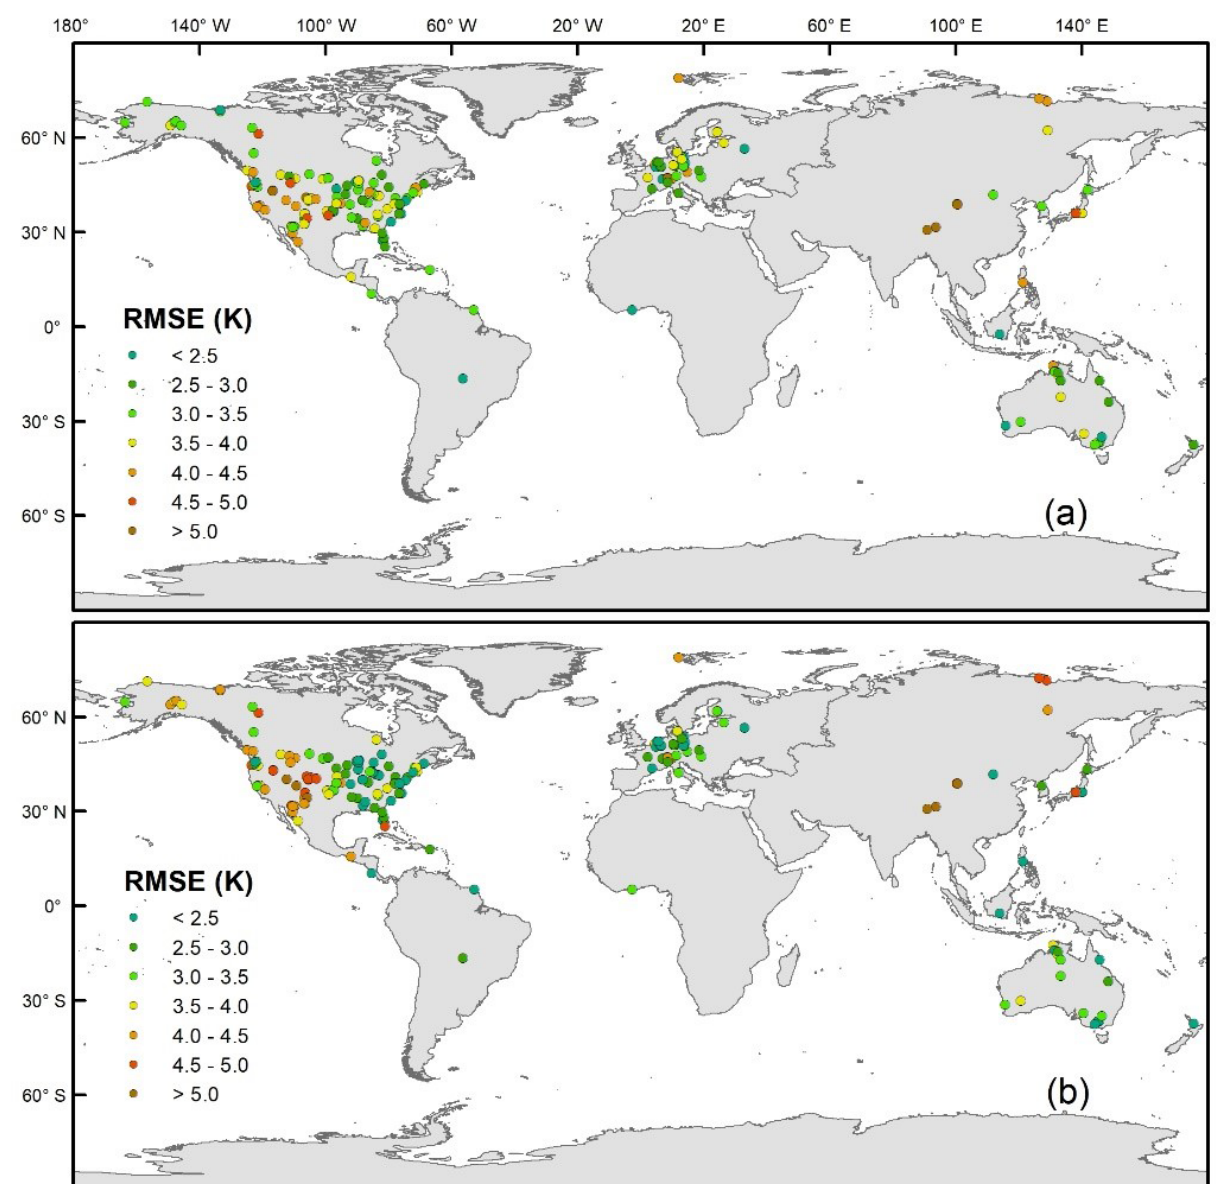
Figure 6. Global RMSE statistics at individual sites under (a) clear-sky and (b) cloudy-sky